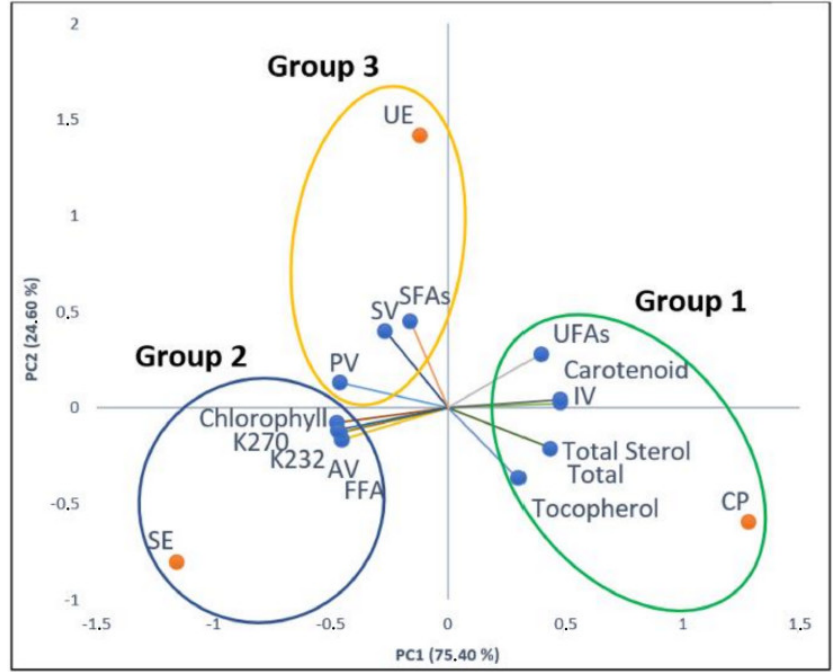
Figure 1. PCA score plot of the first two principal components (PC1 (75.40%); PC2 (24.6%)) of walnut seed oils extracted by different methods.